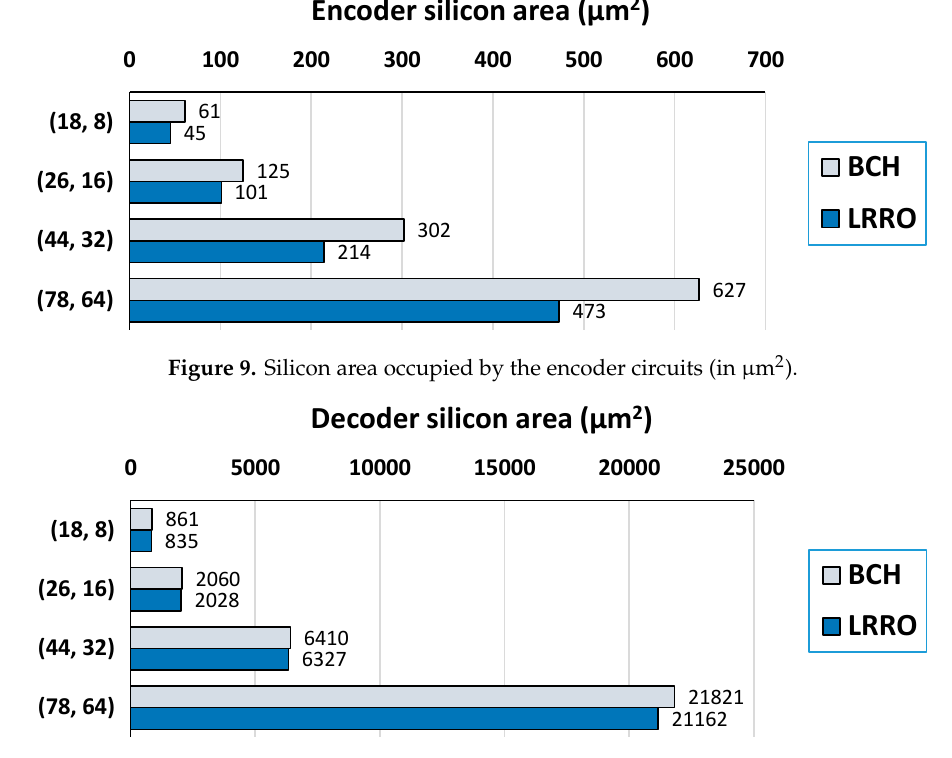
Figure 9. Silicon area occupied by the encoder circuits (in µm 2 ).